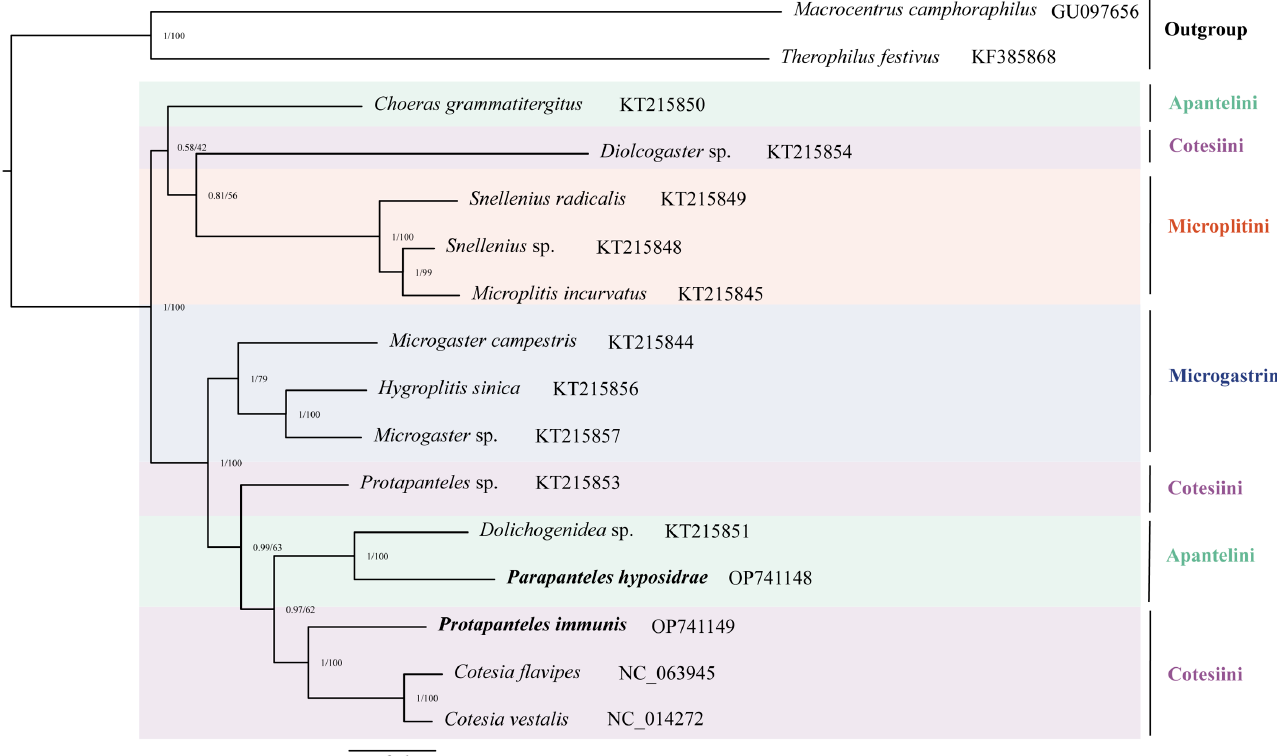
Figure 3. Gene rearrangement in the mitochondrial genome of Pa. hypsidrae and Pr. immunis .